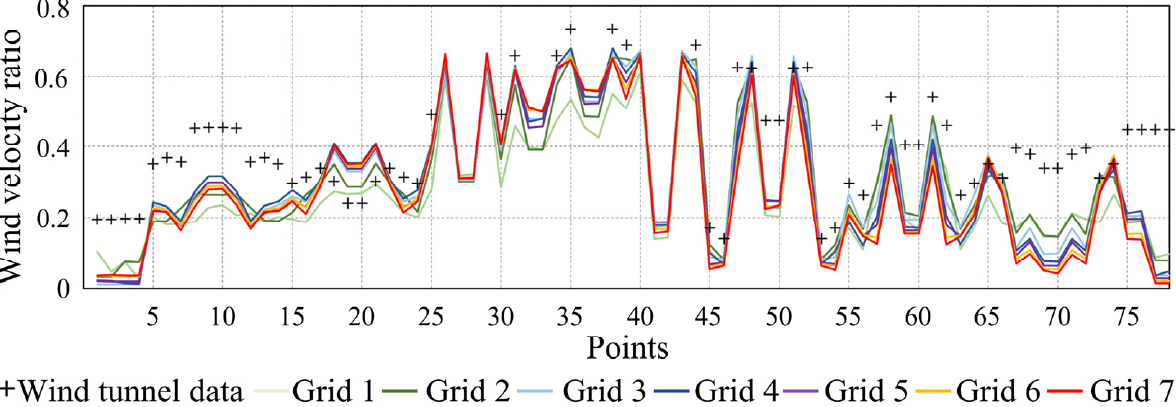
Figure 4. Comparison of wind velocity ratio at pedestrian level obtained by different grid schemes of Butterfly corresponding to 0° wind direction. Wind velocity ratio is the ratio of simulated wind velocity U to reference wind velocity U ref (6.65 m/s).